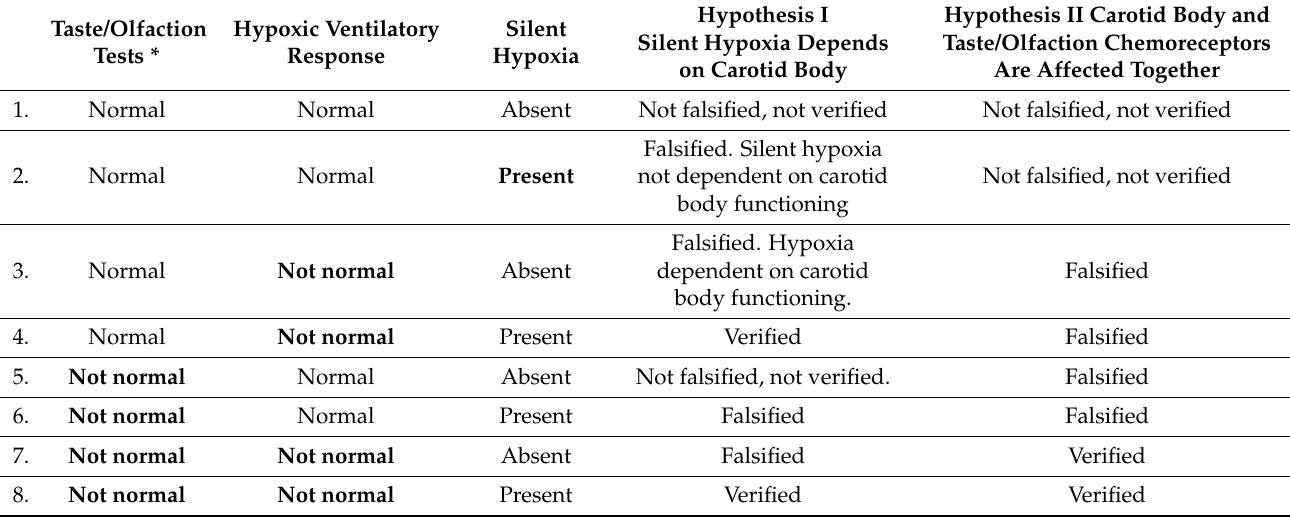
Table 1. A synopsis of the possible findings in patients, at